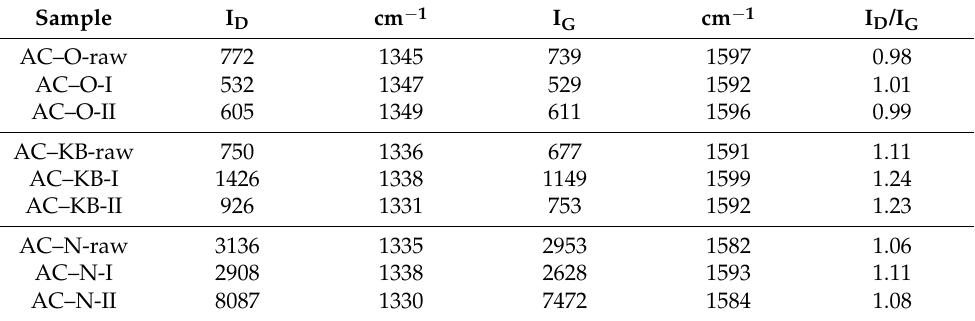
Figure 5. Raman spectra of all investigated series of the obtained samples: ( a ) AC–O; ( b ) AC–KB; and ( c ) AC–N. Table 3. D and G band data of Raman